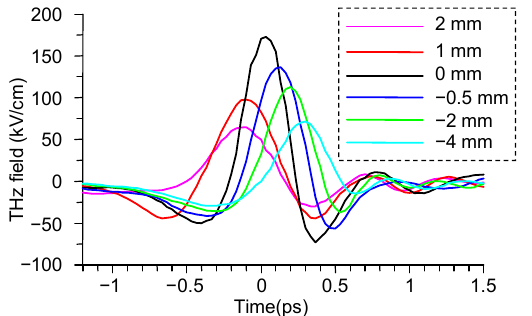
Figure 4. Terahertz electric field waveforms at different z (shown in the inset) along beam path (see Figure 1b).